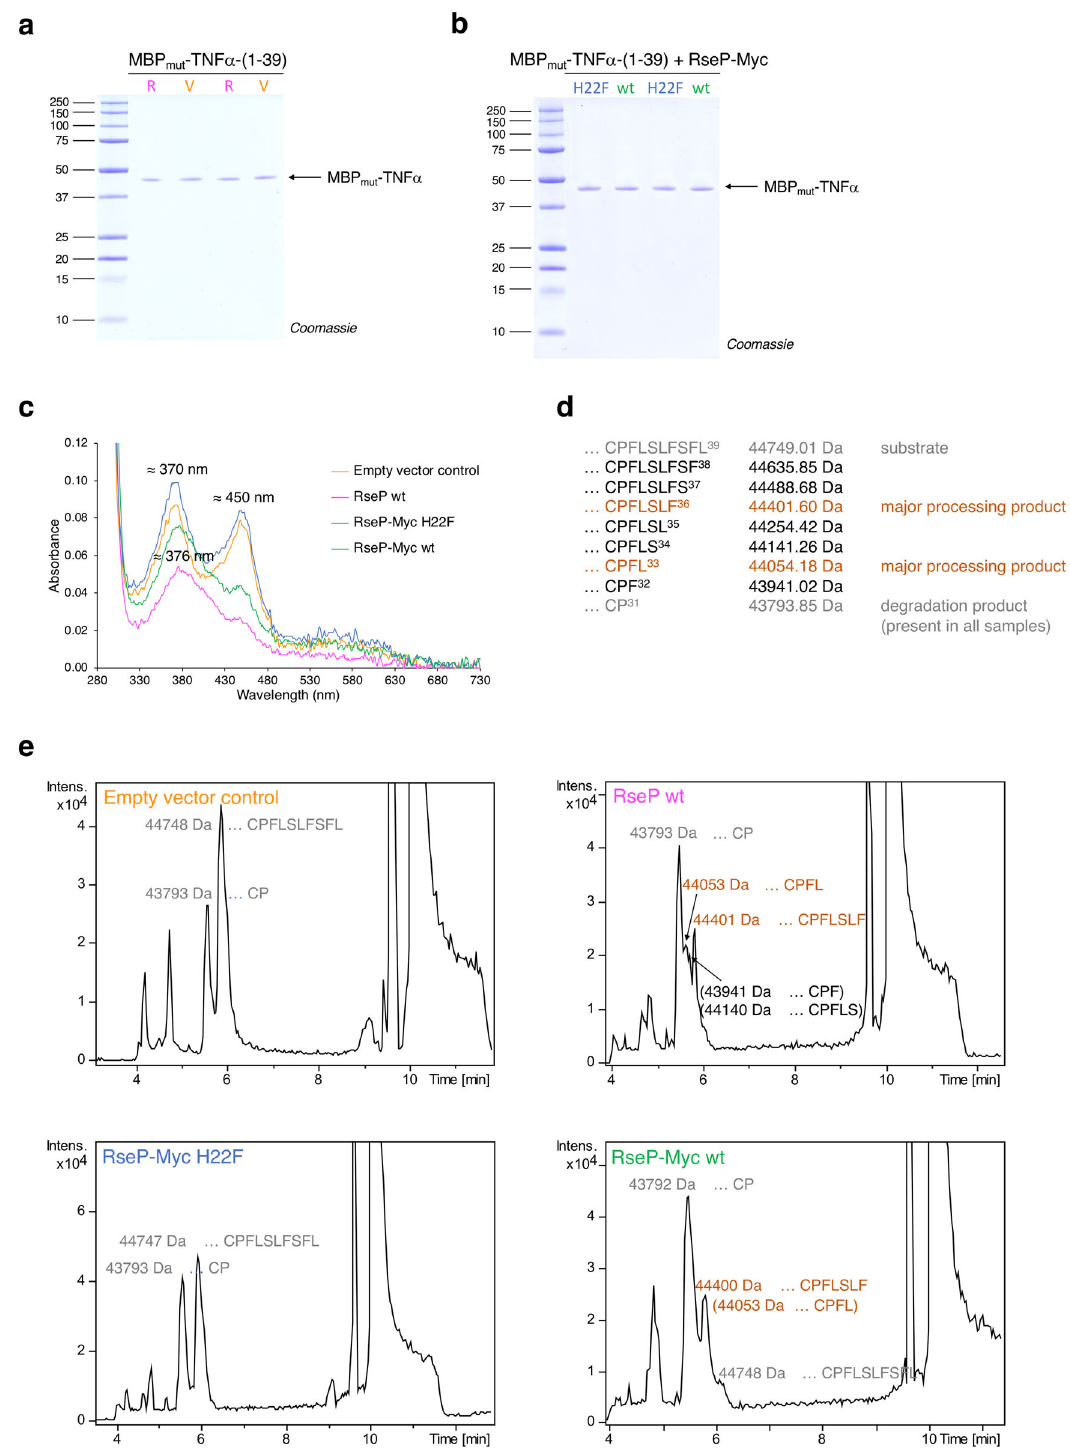
spectrometric analysis suggests a processive cleavage mechanism of RseP and also gives insights into the speci fi city of RseP. Combining error-prone mutagenesis of RseP with iCliPSpy . To identify residues in RseP that are critical for protease activity and/ error-prone mutagenesis of the rseP gene (Fig. 6a, b). We